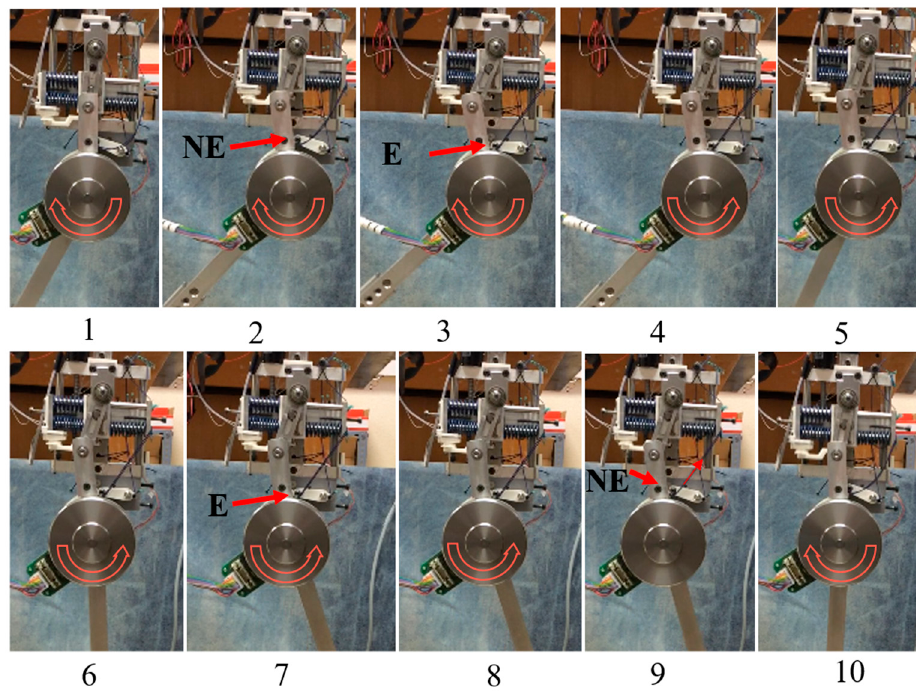
Figure 13. ARES-XL locking and unlocking sequence. Locking: not engaged (NE); engaged (E).